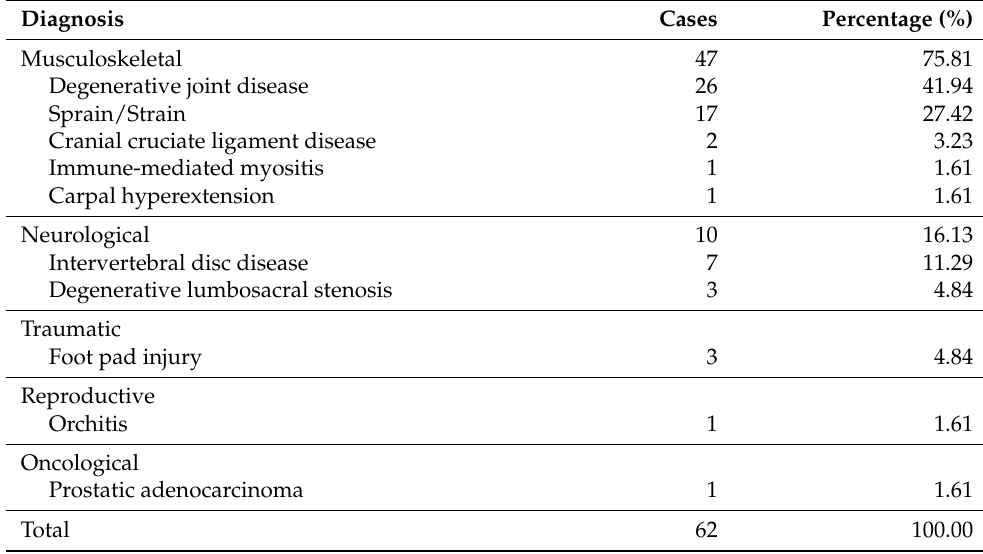
Table 8. Definitive diagnoses for MWDs with gait